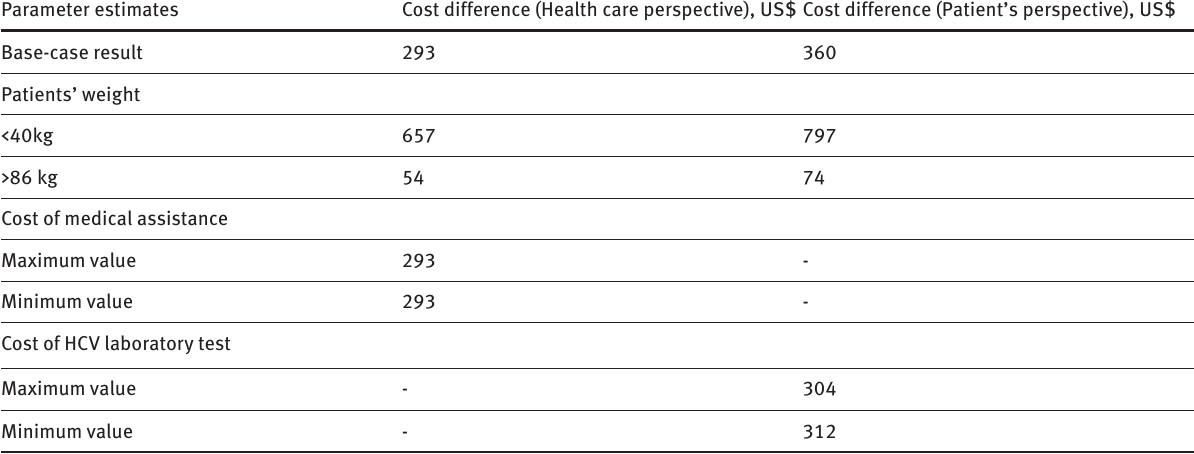
Table 4: Sensitivity of cost differences to uncertainty in input values (per patient) Parameter